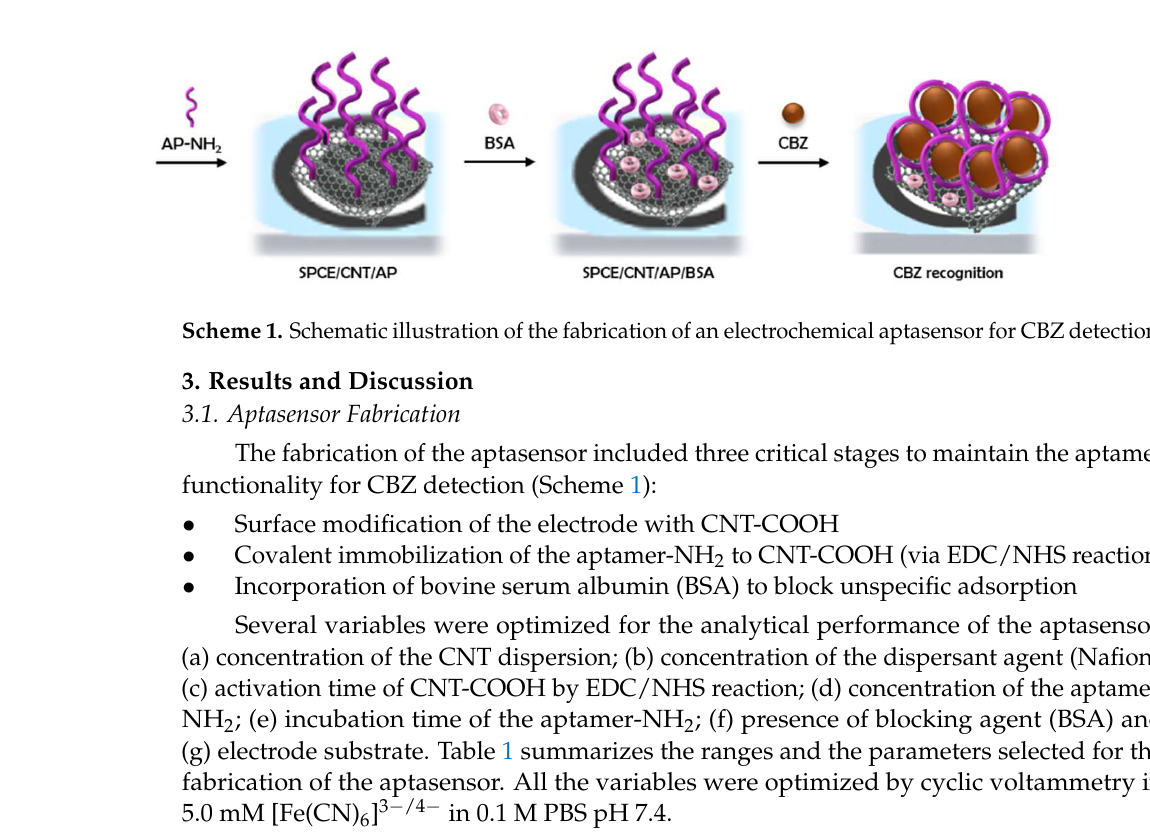
Table 1. Optimization of the variables in the fabrication of the aptasensor. Variable Range Tested Selected Value The concentration of CNT dispersion, mg/mL Concentration of Nafion ® in the dispersion, % ( v / v